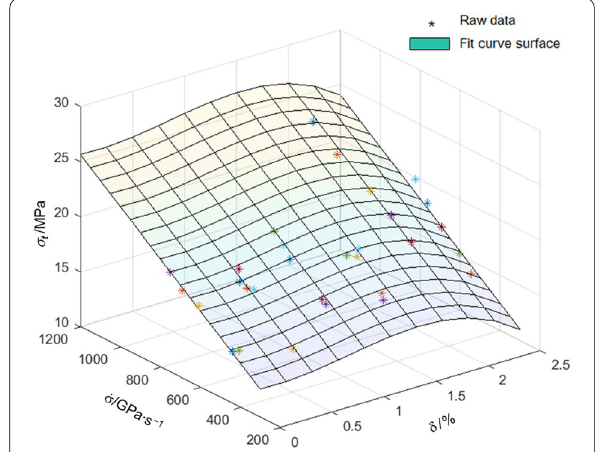
Fig. 9 Verification diagram of fit